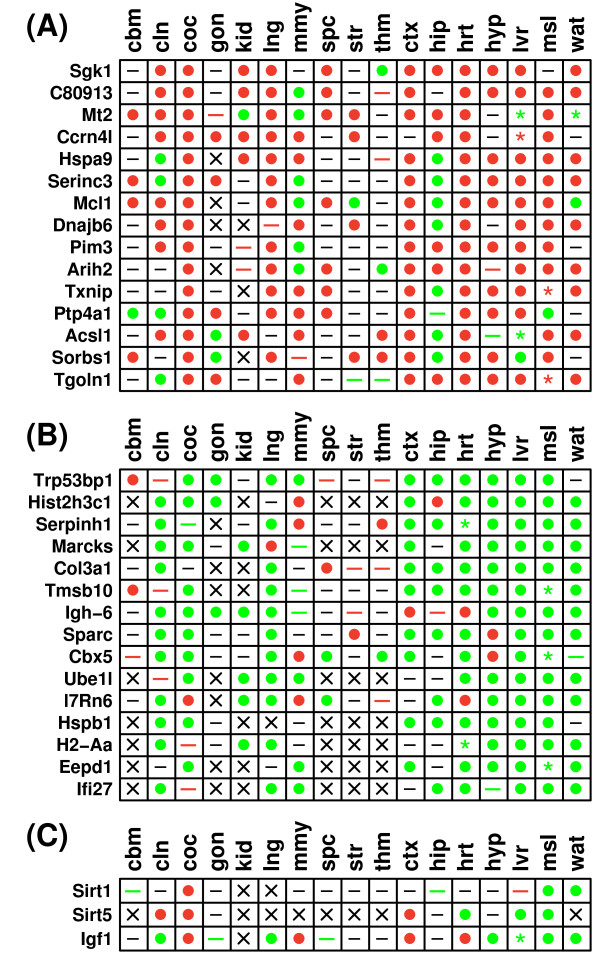
Common gene expression responses to CR in the laboratory mouse. Common gene expression responses to CR are ranked according to the number of tissue types in which genes were (A) significantly up regulated by CR or (B) significantly down regulated by CR. Additional File 5 provides a more comprehensive list of genes significantly regulated by CR across tissues, with genes ranked by p-values generated from Fisher's method. Genes shown in part (C) were not identified as common responses to CR, but have previously been associated with the mammalian CR response. Symbols shown within the grid reflect results of differential expression analyses for individual genes and tissues, given a comparison-wise type I error rate of 0.05 (i.e., no p-value adjustment for multiple testing of hypotheses). Filled circles indicate that a gene was significantly up regulated by CR (red circle) (Pu < 0.05) or significantly down regulated by CR (green circle) (Pd < 0.05) within a given tissue. The dash symbol is used to indicate cases in which the effects of CR are non-significant, although colored dash symbols indicate that expression is marginally increased by CR (red dash) (0.05 < Pu < 0.10), or marginally decreased by CR (green dash) (0.05 < Pd < 0.10). The asterisk symbol (✴) is used to designate instances where CR has significant effects, but there exists conflict among datasets. This may arise if at least two experiments exist, with at least one showing significant up regulation by CR (Pu < 0.05), and at least one demonstrating significant down regulation by CR (Pd < 0.05). Additionally, the asterisk is used when p-values, generated by combining results across experiments (Fisher's method), yield conflicting results in terms of whether a gene is up or down regulated (i.e., both Pu < 0.05 and Pd < 0.05). Asterisk symbols are colored red if there is stronger evidence that the gene is up regulated by CR (i.e., Pu < 0.05 and Pu < Pd), and are colored green if there is stronger evidence that the gene is down regulated by CR (i.e., Pd < 0.05 and Pd < Pu). The multiplication symbol (×) is used for cases in which no information was available regarding the effects of CR within a given tissue.